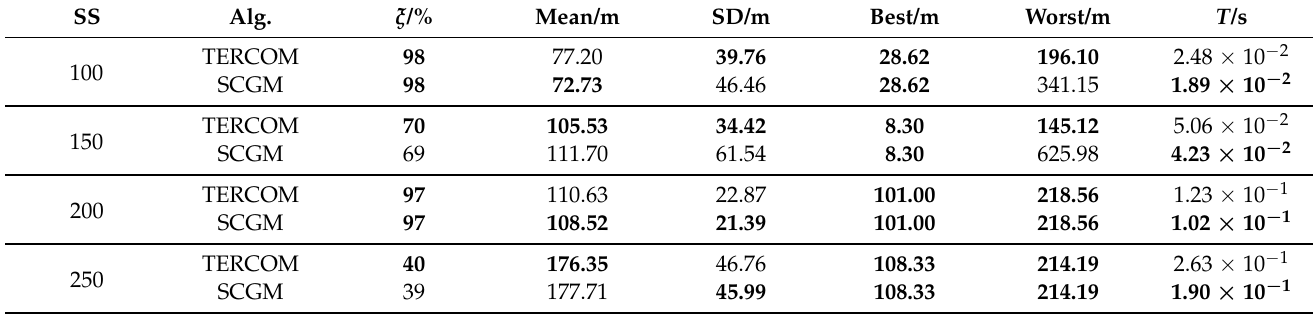
Table 2. Statistical results of two kinds of gravity matching models under different sampling